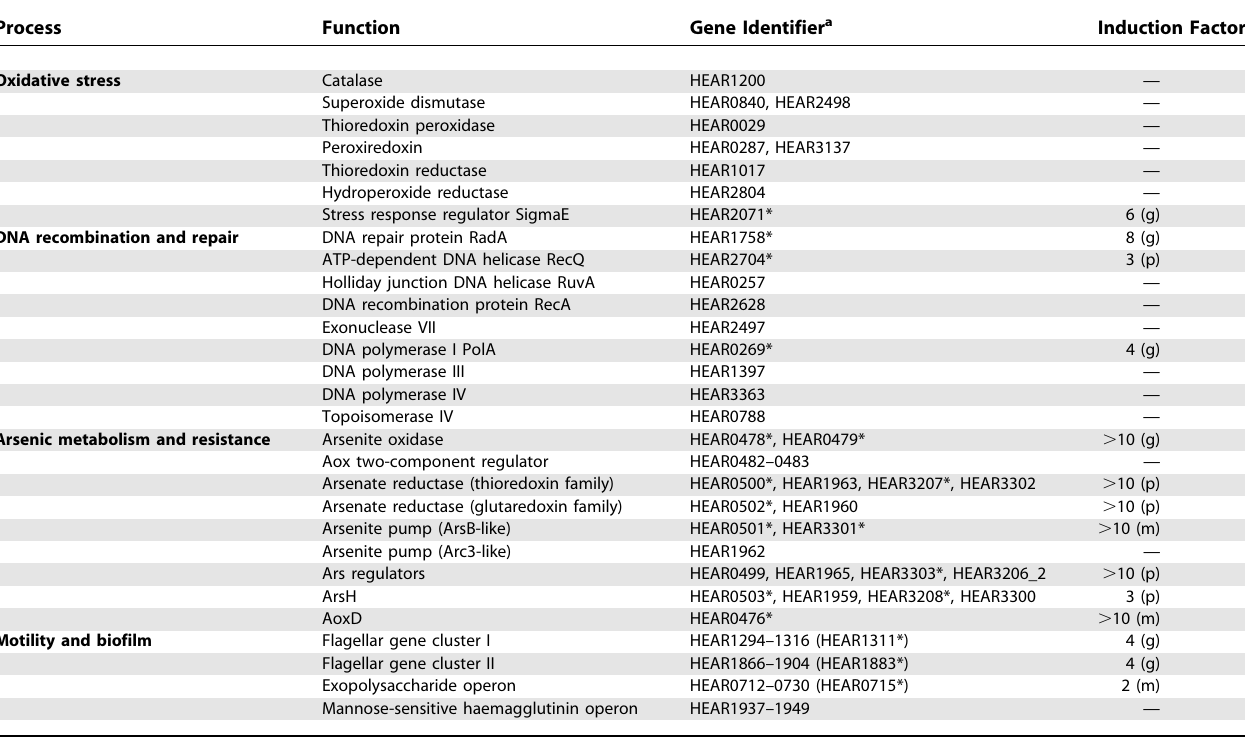
Table 2. Genetic Determinants of Arsenic-Related Stress Adaptation